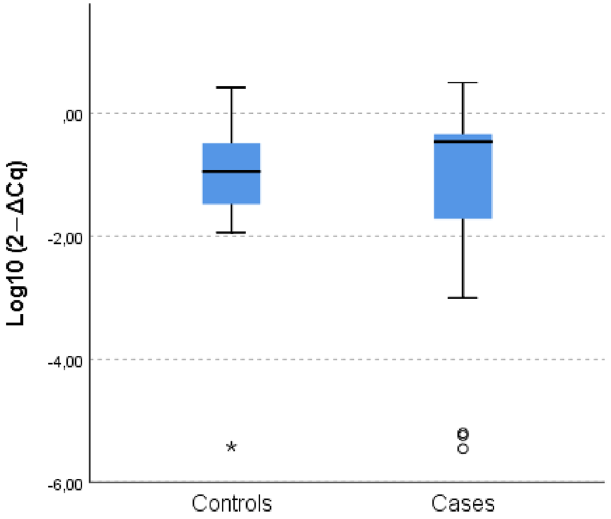
Figure 1. Relative quantification of Fusobacterium nucleatum level in saliva, in case and control groups. Fusobacterium nucleatum level in saliva specimens is measured by qPCR as 2 −